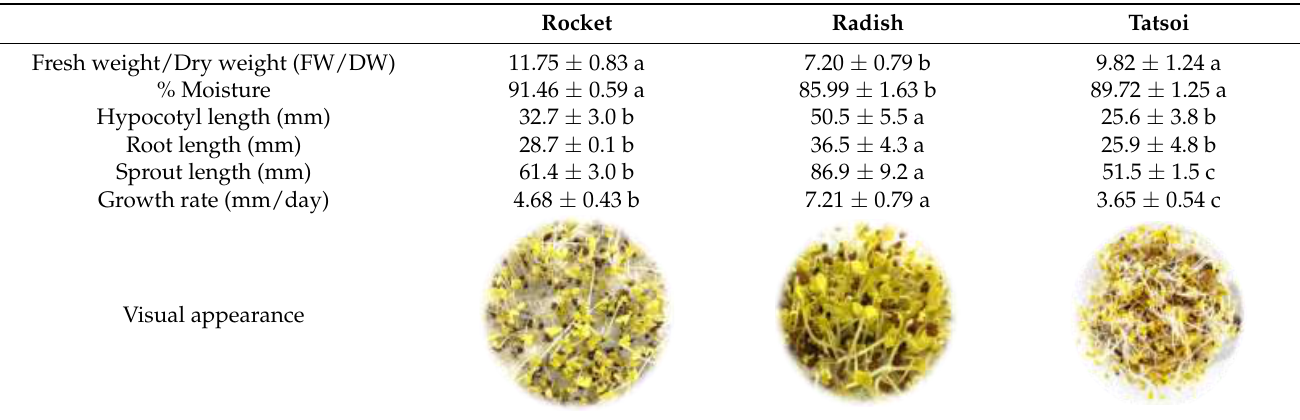
Figure 3. Color appearance of Brassicaceae sprouts after 5 days at 5 °C illuminated under different wavelengths of the electromagnetic spectrum. Table 1. Initial sprout characterization after 7 days growing.